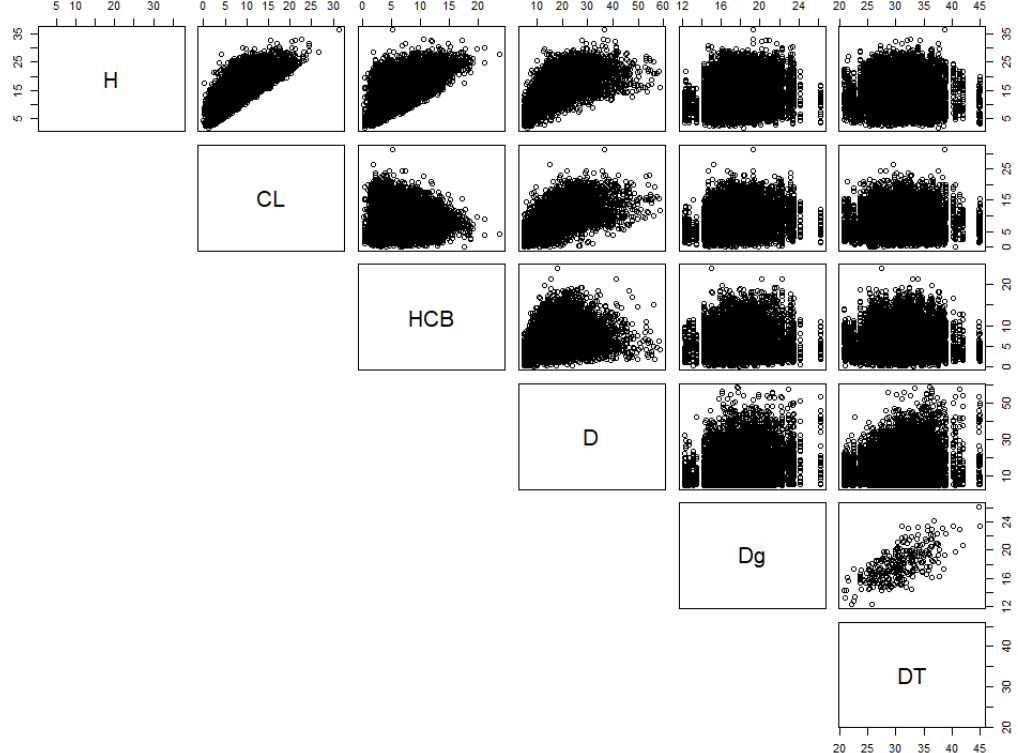
Figure 1. The relationships of individual tree H (total tree height), CL (crown length), HCB (height to live crown base) with individual tree factors, including D , Dg , and DT ( H : total tree height (m); CL : crown length (m); HCB : height to live crown base (m); D : diameter at breast height (cm); Dg : mean quadratic D (cm); DT : stand dominant D (cm).